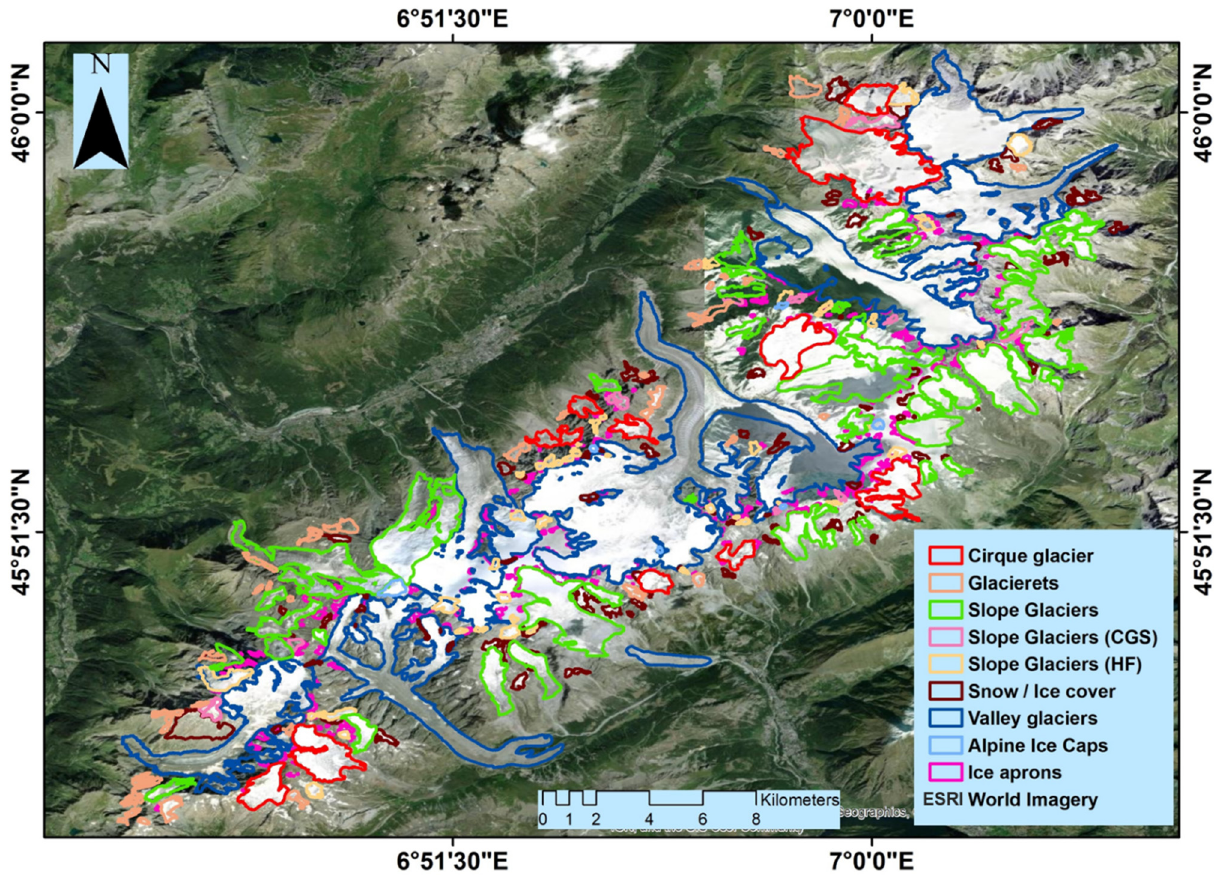
Figure 7. High-resolution typology map of the glaciers of the MBM. Table 2. Glacier types, numbers, and areas in the